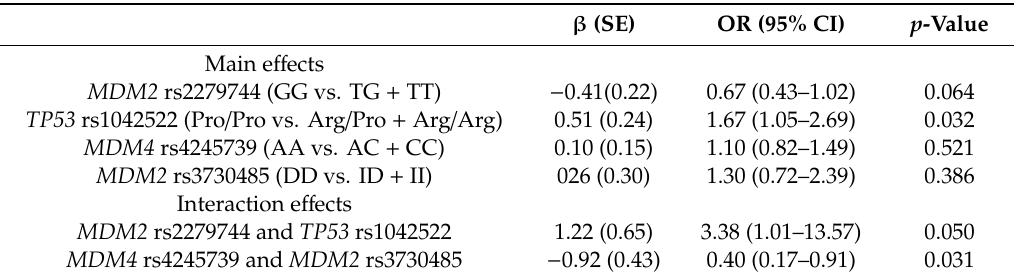
Table 3. Logistic regression results with the main e ff ects and gene–gene interaction terms according to the recessive genetic